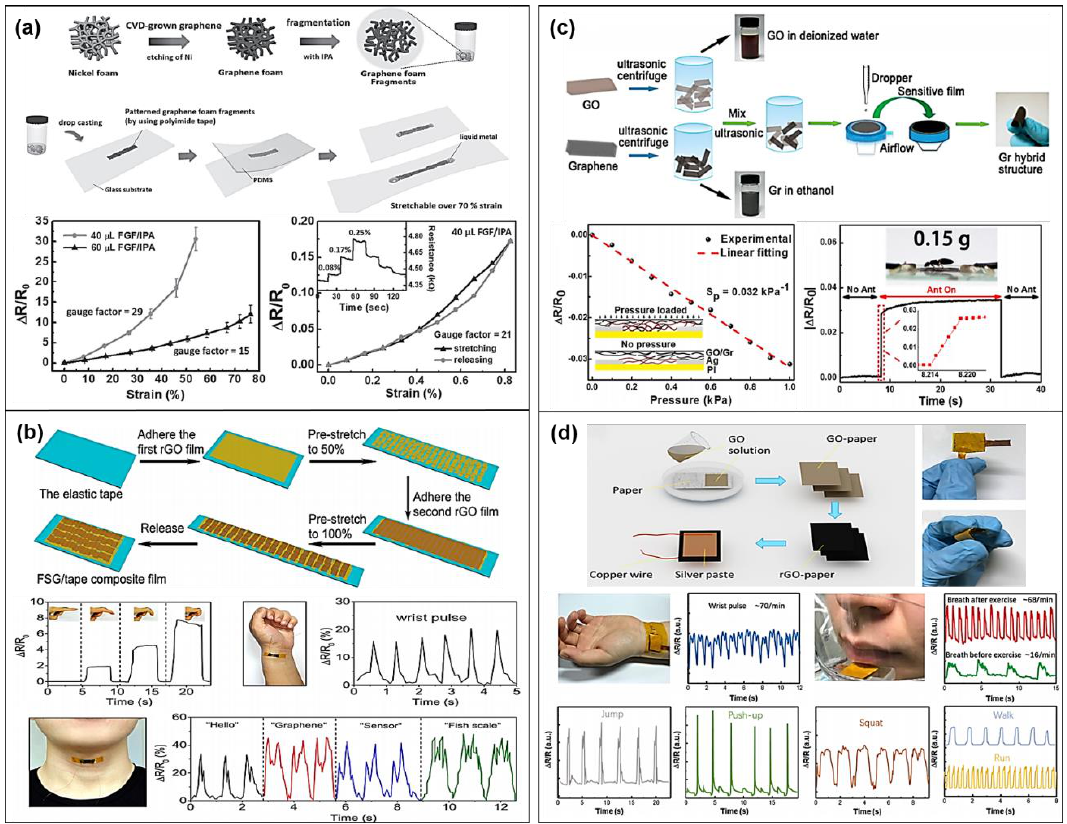
Figure 3. Graphene-based activity sensors. Strain sensors; ( a ) fragmentized graphene foam (FGF) and the relative resistance change of the sensor with di ff erent content of FGF with isopropyl alcohol (IPA) under strain (Reproduced with permission [53] copyright 2015, Wiley-VCH). ( b ) Schematic illustration of fabricating a fish-scale-like rGO strain sensor (FSG) and relative resistance responses of FSG strain sensor (reproduced with permission [66] copyright 2016, American Chemical Society). Pressure sensors; ( c ) a hybrid structure GO / Gr (graphene) pressure sensor using graphene oxide-assisted dispersion